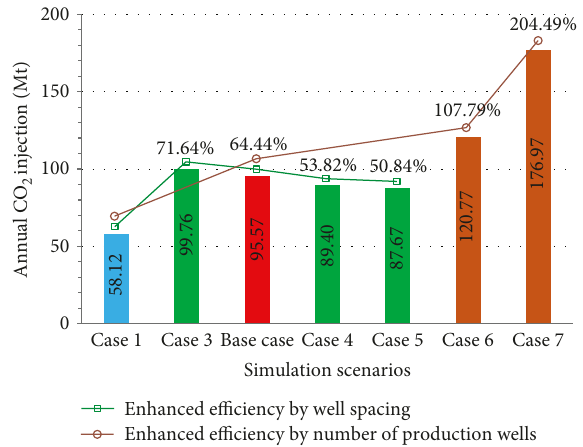
Figure 10: In fl uence of the arrangement of the production wells on the CO injection 2